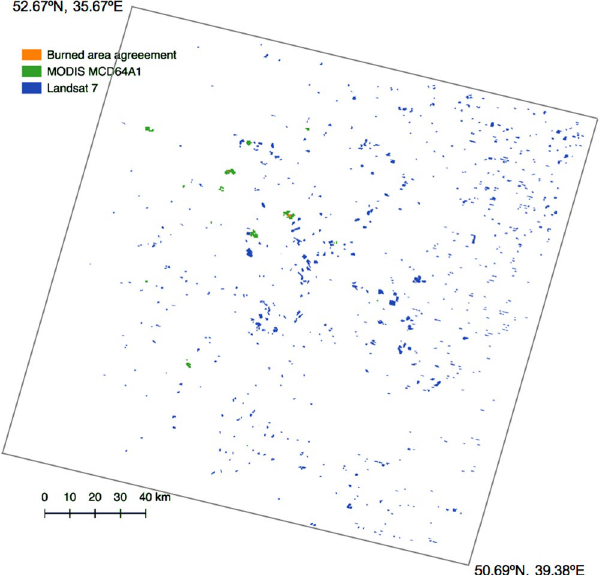
Figure 4. Burned area map showing a comparison of MCD64A1 and Landsat 7 ETM + products for croplands in region id 1 in Fig.